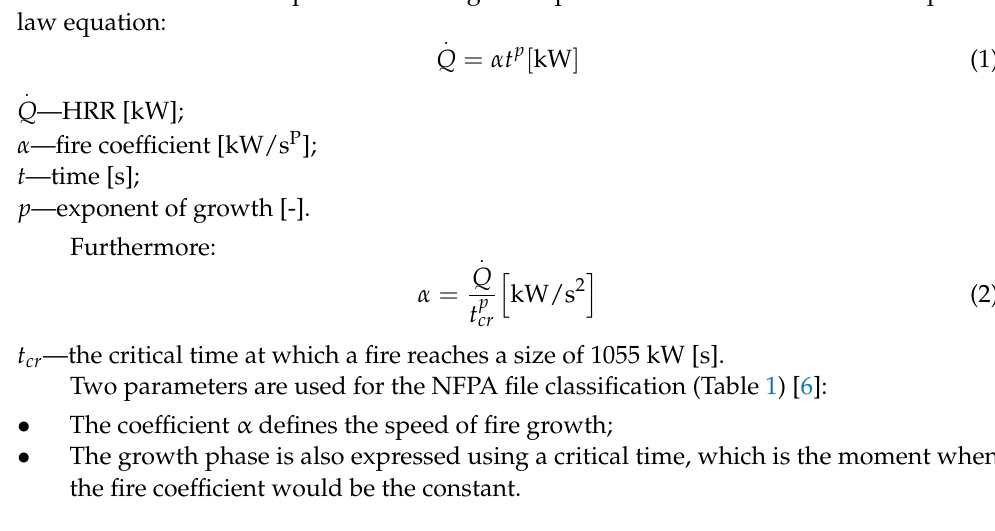
Table 1. NFPA 72 “National Fire Alarm Code”, 2013 edition. Fire Classifications NFPA 72 Slow